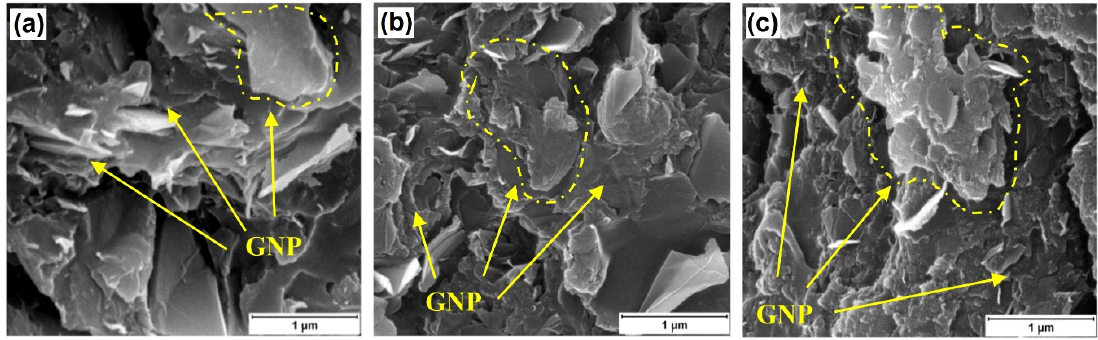
Figure 8. SEM of fracture surface of GNP/epoxy nanocomposite containing 10 wt % GNP at ( a ) C-300; ( b ) C-500; ( c ) C-750.